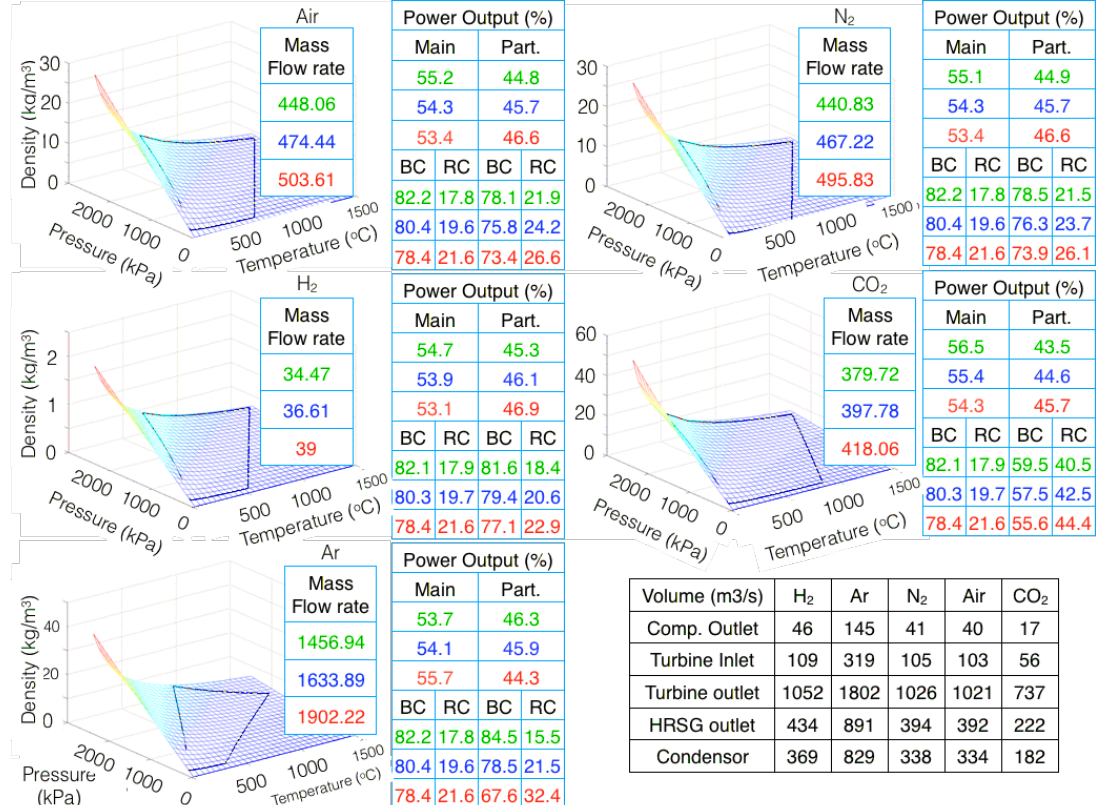
Figure 9. Density data for different fluids shown as 3D surface plots. Black lines represent the entropy profiles of the partitioned Brayton cycle at 92.7% adiabatic efficiency. Adjacent tables provide the mass flow rates and load distribution between the main, partitioned cycle, Brayton cycle, and Rankine cycle. Green, blue, and red represent these losses at adiabatic efficiencies of 95.63%, 92.7%, and 89.9%, respectively. The main table provides the volumetric flow rates at different locations of partitioned cycle (η = 92.7%).